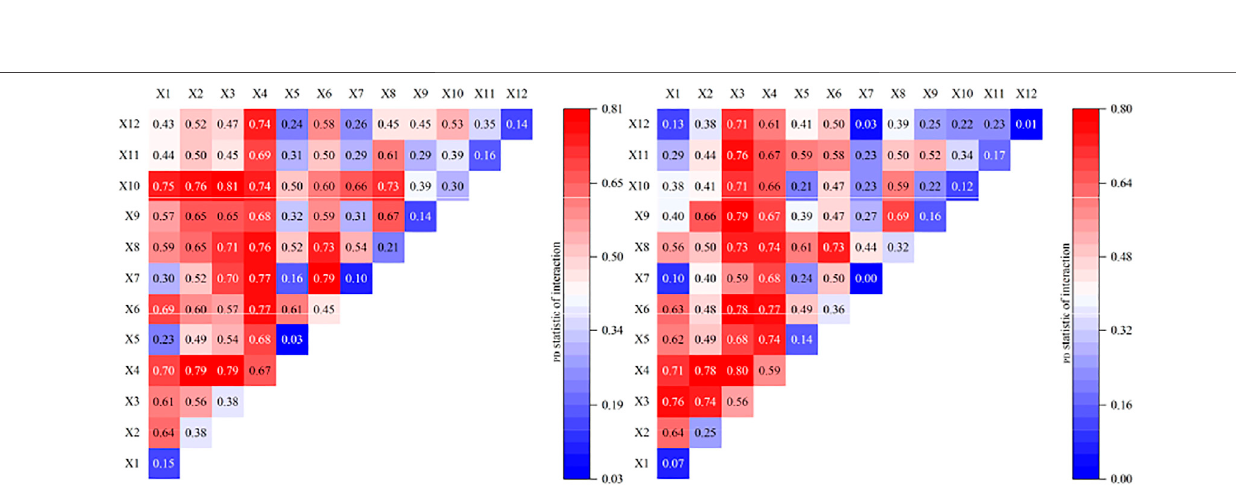
FIGURE 11 | Interaction detector results of driving factors on carbon emission in 2003 and 2019.